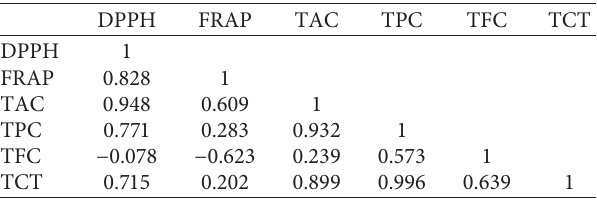
Table 4: Correlation established between phenolic compounds and antioxidant activity of hydromethanolic extracts by different